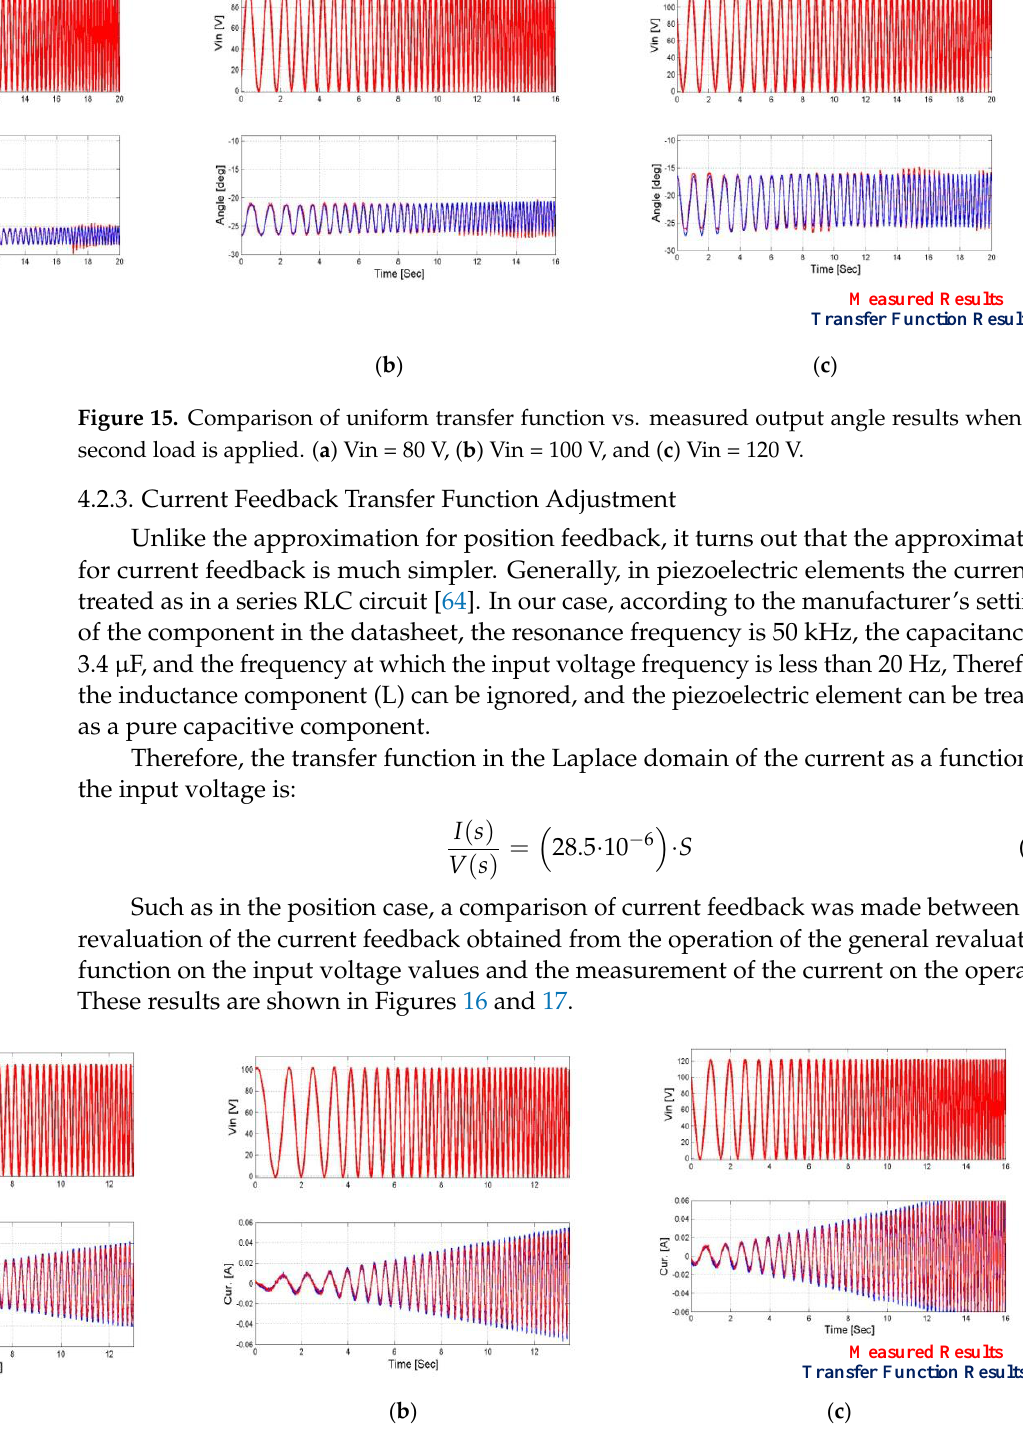
Figure 16. Comparison of uniform transfer function vs. measured output current results when the first load is applied. ( a ) Vin = 80 V, ( b ) Vin = 100 V, and ( c ) Vin = 120 V.